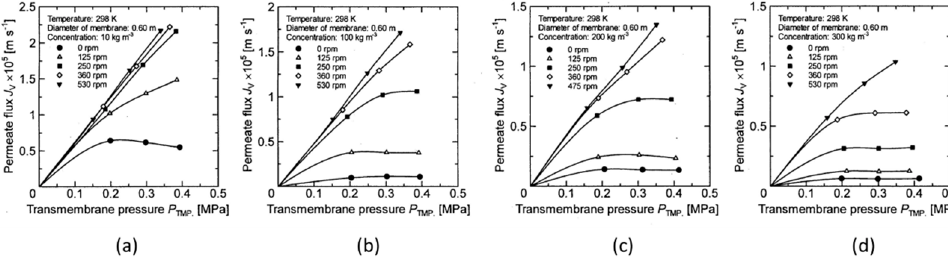
Figure 7. Relationship between measured TMP and permeate flux for disk diameter 0.6 m. ( a ) at